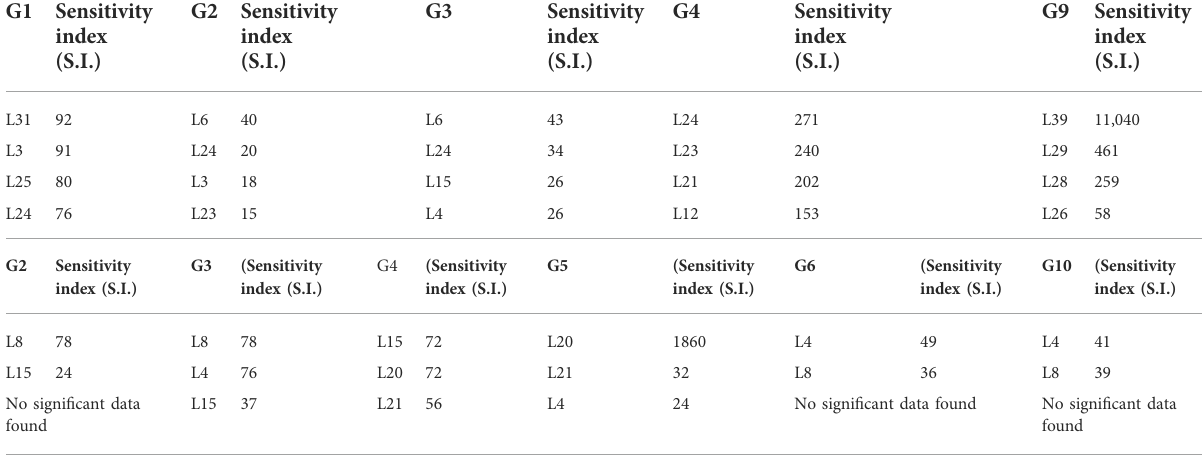
TABLE 1 (A) Load generator sensitivity indexes for rotor speed regulation. (B) Load generator sensitivity indexes for generator voltage regulation.